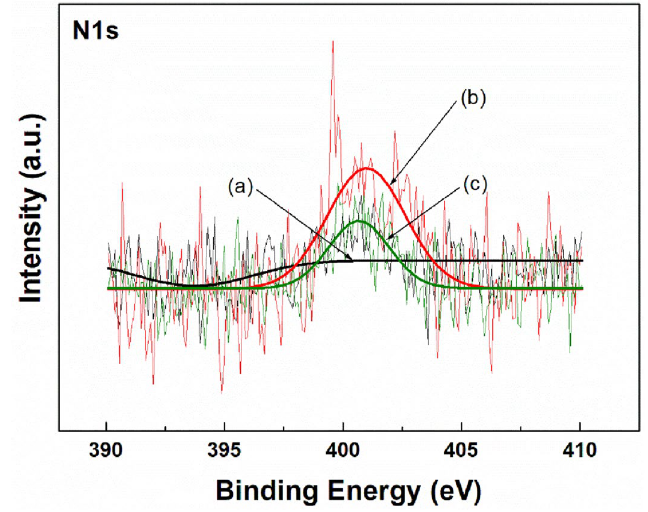
Fig. 7 XPS narrow scans of cotton fabrics: a dyed with Aronia berries extract, b dyed with Aronia berries extract–chitosan mixture, and c dyed with Aronia berries extract after chitosan